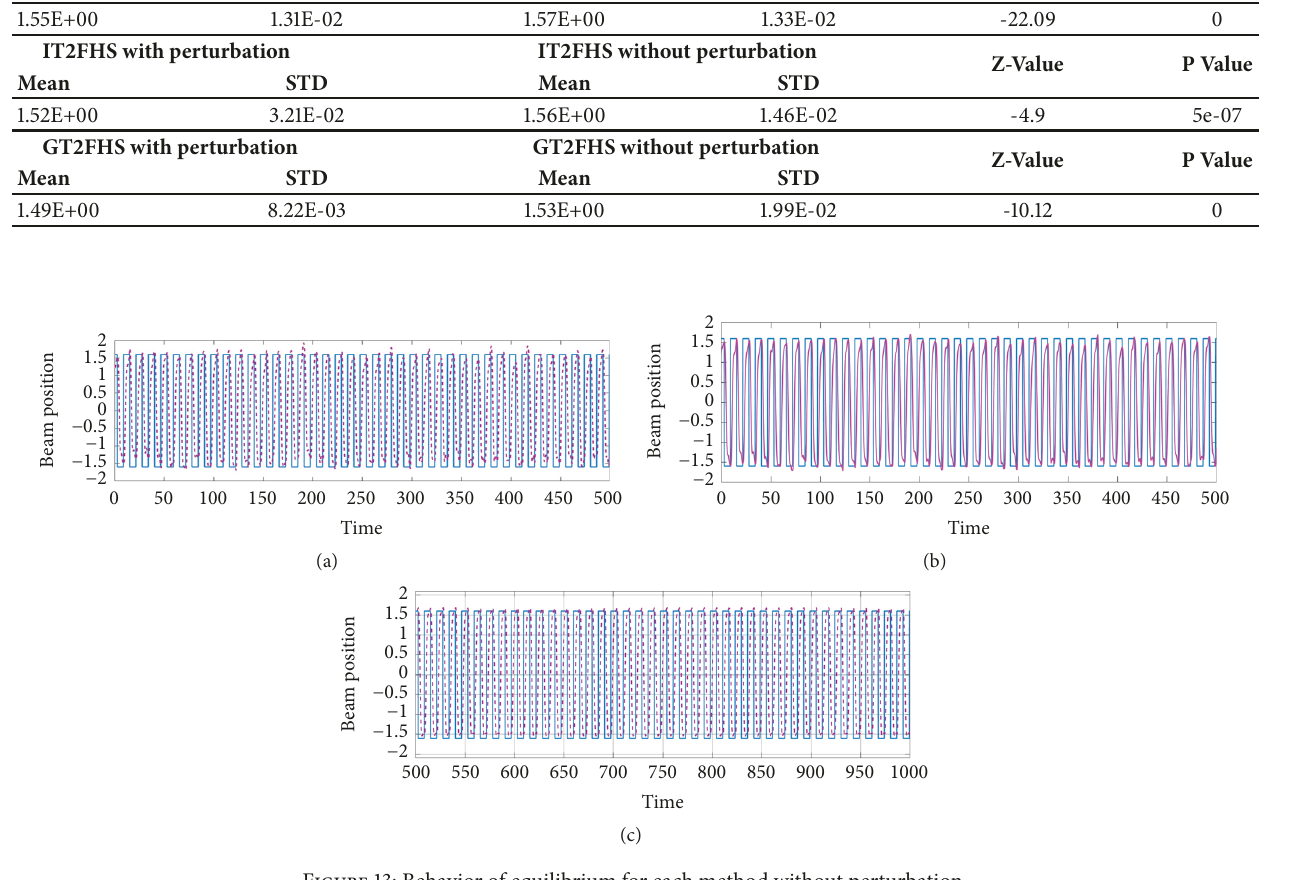
Figure 13: Behavior of equilibrium for each method without perturbation.